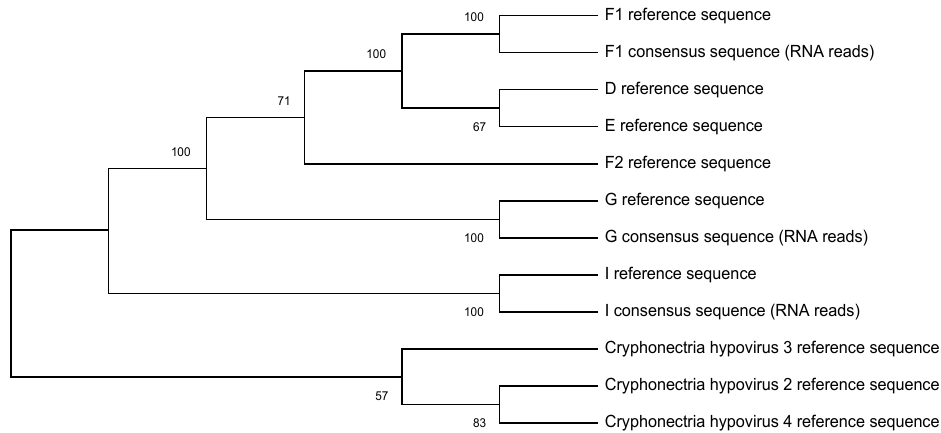
Figure 1. Shown is a maximum likelihood phylogeny estimated in MegaX. Included are the reference sequences for each subtype and CHV species, as well as the consensus sequences from Wtbdg2 for each subtype sequenced with direct RNA sequencing. Table 2. BLAST analysis for raw sequencing reads. Shown are the number reads with the top BLAST hit to CHV-1 or other CHV species for each sequencing library. PI—mean percentage identity of the top hits. Underlined values denote an incorrect subtype assignment.